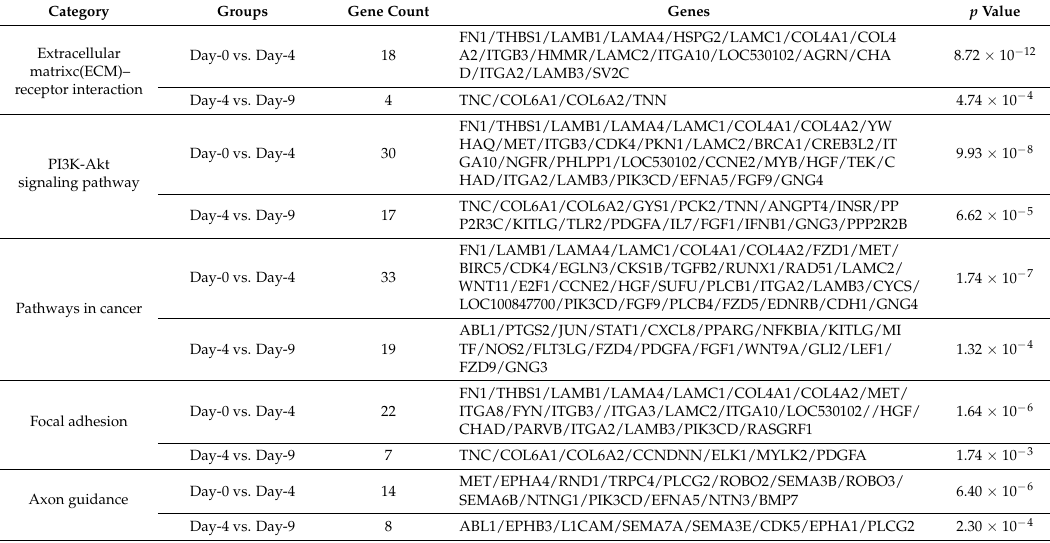
Figure 5. Kyoto Encyclopedia of Genes and genomes (KEGG) functional annotations of unigenes in the Yan Yellow cattle transcriptome. The scatter diagram shows enrichment of DEGs in the signaling pathways. The X-axis label represents GeneRatio (GeneRatio = amount of DEGs enriched in the pathway/amount of all genes in annotation gene set), and the Y-axis label represents the pathway ( p adjust < 0.05). Table 3. Summary of pathways associated with DEGs between early and late stage groups using KEGG pathway